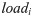
Extension and constriction of the CEL, and load changes on edges after picking up one load.(a) Extension, (b) constriction. (The circled number represents the number of loads; i.e., loadi represents the load carried by the robot as it passes edge i; the dashed line in Fig 7A represents the LKH edges that have not been appended to the CEL; low and up, respectively, point to the first and last edges in the CEL. Triangles represent p-nodes, hollow circles represent d-nodes to be filled, and solid circles represent filled nodes.).